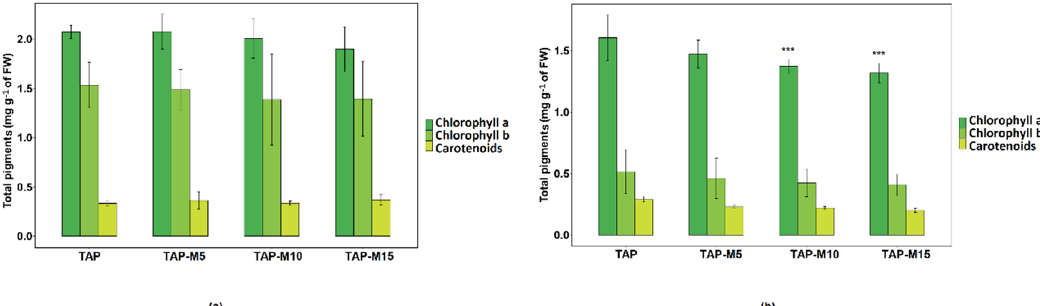
Figure 5. Total pigments of Chlamydomonas sp. MACC-216 ( a ) and Chlorella sp. MACC-360 ( b ) in TAP, TAP-M5, TAP-M10 and TAP-M15 media. Error bars represent standard deviations; asterisks (***) denote level of significance.